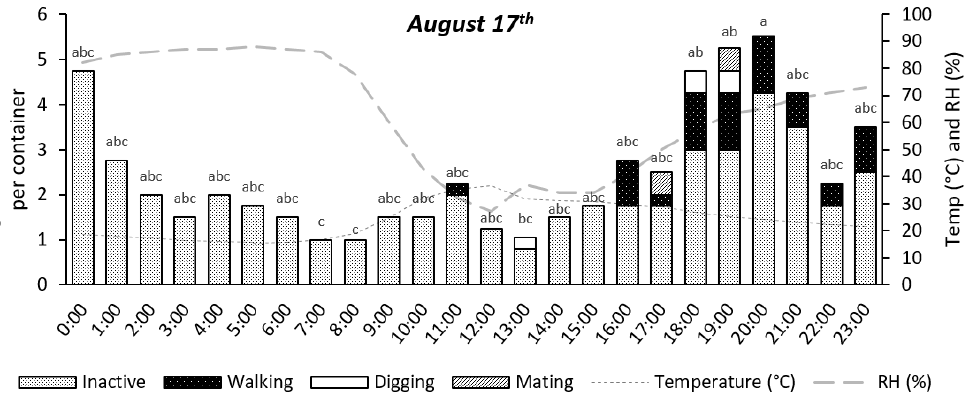
Figure 5. Number of visible S. levis adults per container at every hour on 17 August considering insect activity, temperature (temp) and relative humidity (RH%). Bars with mean values followed by same letter are not different at α = 0.05.